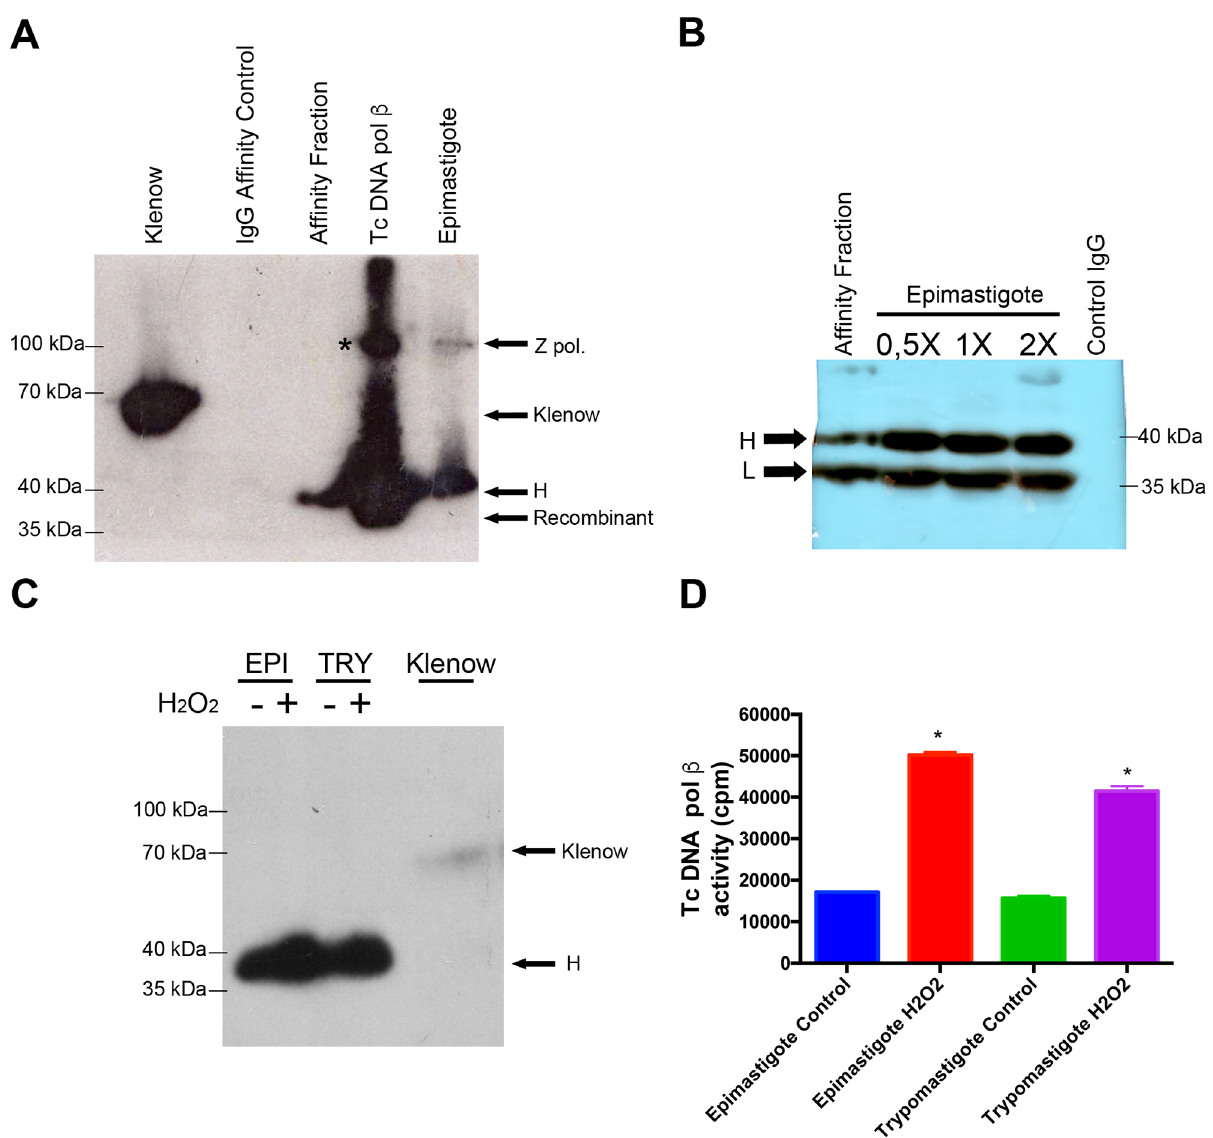
Fig 3. Measurement of DNA synthesis in activity gels. (A) SDS-PAGE activity gels were loaded with 100 pg of Klenow fragment (control), 15 μ l of purified Tc DNA polymerase β (Affinity Fraction), 500 pg of recombinant Tc DNA polymerase β and 1 μg of epimastigote cell extract (Epimastigote). Then the gel was processed to evaluate in-gel DNA synthesis (see Methods). Z pol indicates the position of Tc DNA polymerase z detected in the epimastigote fraction. H indicates the position of the large form of Tc DNA polymerase β (detected in affinity fraction and epimastigote). (B) Western blot of the samples analyzed in (A). Three different amounts of epimastigote cell extract were evaluated: 0.5, 1 and 2 μg (0.5X, 1X and 2X respectively). H and L indicate the migration of large and small forms of Tc DNA polymerase β . (C) SDS-PAGE activity gel was loaded with 1 μg of epimastigote (EPI) and trypomastigote (TRY) cell extracts either from peroxide-treated organisms (+) or without treatment (-). (D) Radioactive protein bands were excised from the gel and quantified by liquid scintillation. Results are expressed in cpm (counts per minute) and represent the mean +/- SD of four independent experiments. (cid:3) indicates p < 0,05 between non-treated v/s peroxide-treated organisms.